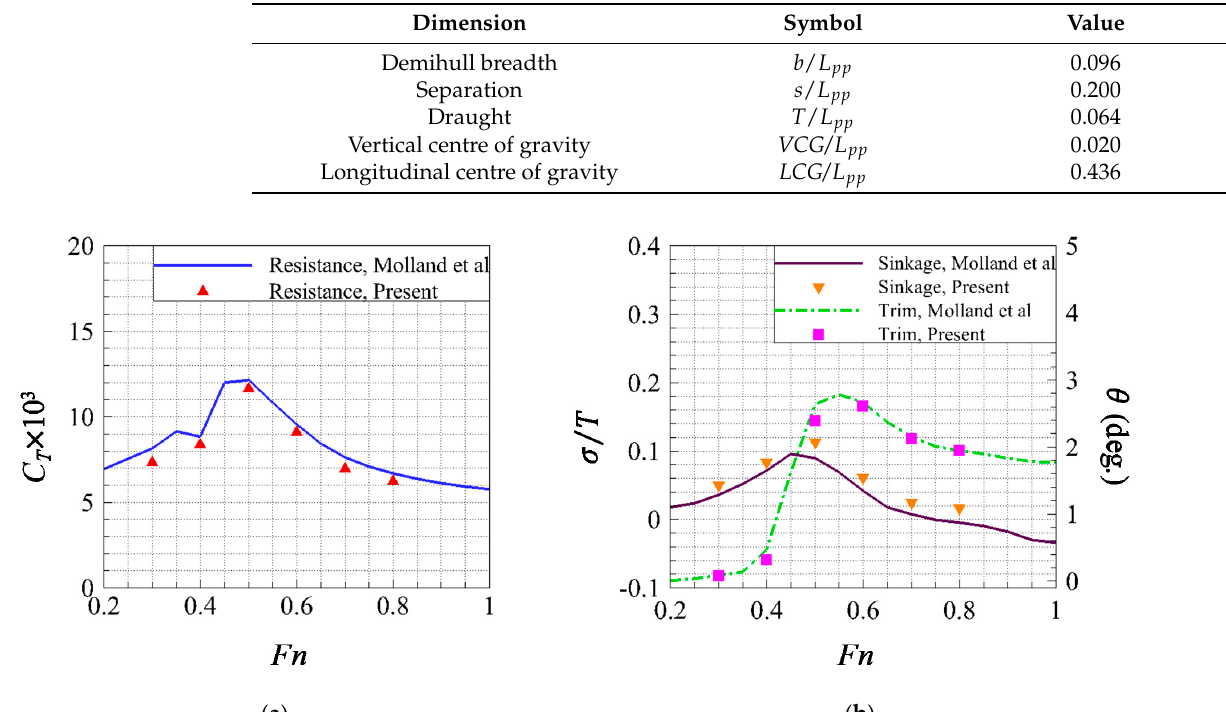
Figure 5. Total resistance coefficients ( a ), sinkage and trim ( b ) of NPL 4a02 model.